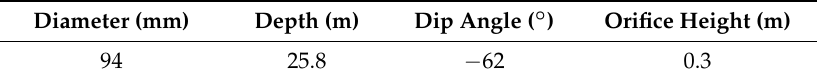
Table 1. Drilling parameters for influence-range determination.